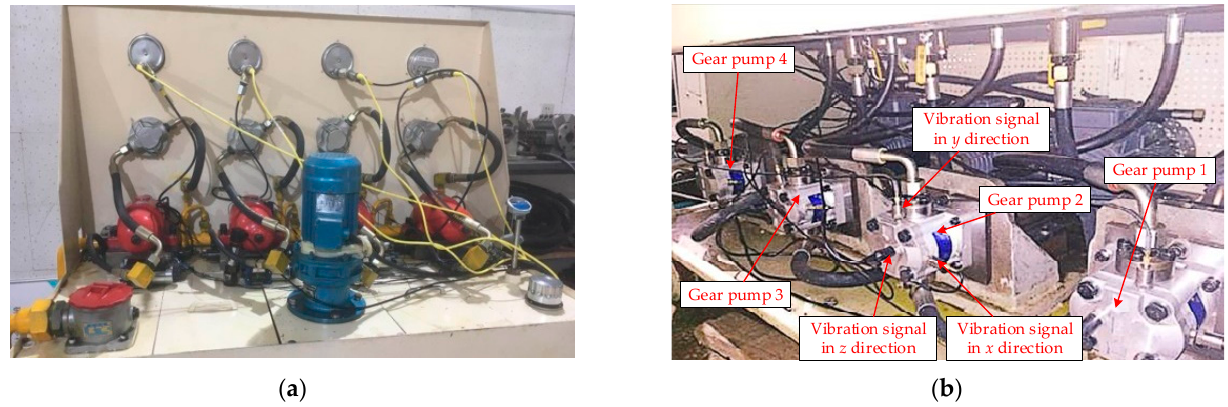
Figure 7. Lifecycle test bed of gear pump: ( a ) topside of test bed; and ( b ) underside of test bed. In this study, the gear pump volumetric efficiency calculation method is: